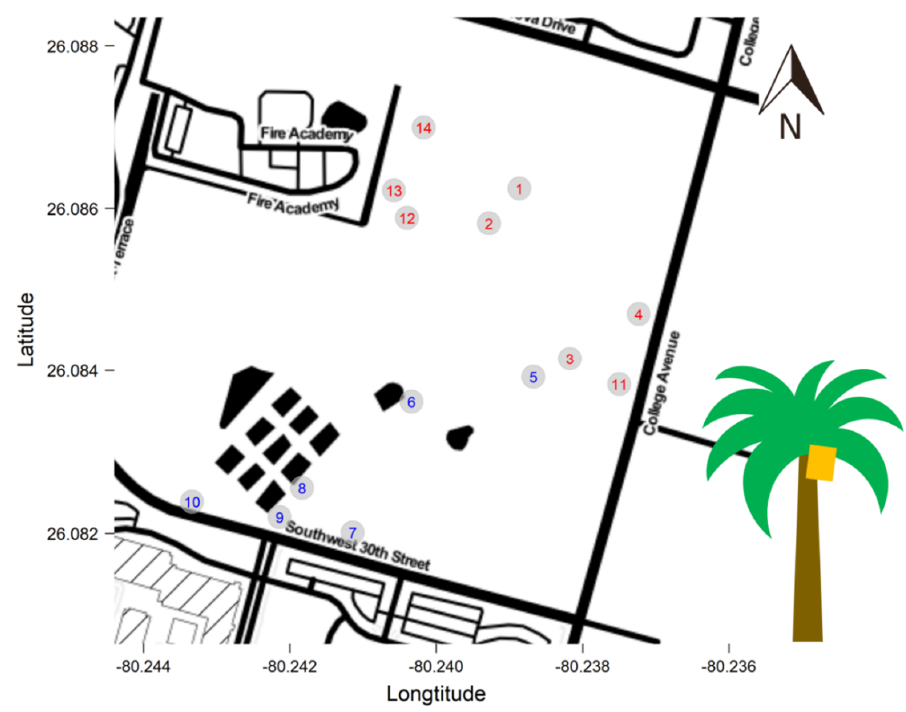
Figure 1. Locations of the palms set up for yellow sticky traps. Lethal bronzing-infected palms (traps 1–4 and traps 11–14) in red and non-infected palms (traps 5–10) in blue.